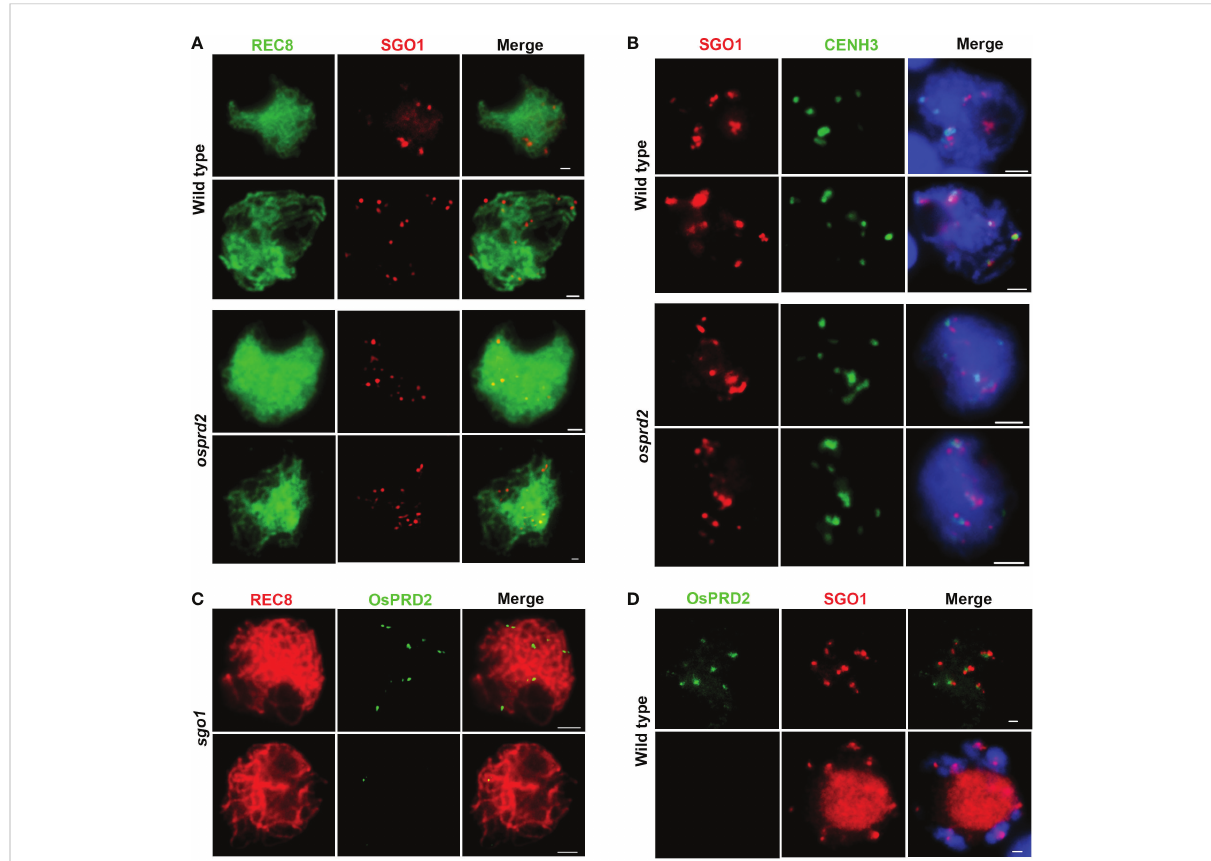
FIGURE 10 Localization of SGO1 and PRD2 at the centromeric region is independent of each other. (A, B) are SGO1 localization in wild type and osprd2 mutant in zygotene and pachytene; (C) is OsPRD2 localization in sgo1 mutant during zygotene and pachytene; (D) is OsPRD2 and SGO1 colocalization in wild type during zygotene and diakinesis. Bar=2 m